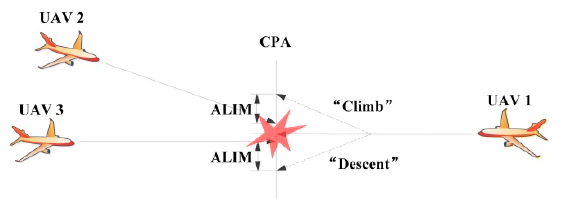
Figure 1. Traffic alert and CA (collision avoidance) system (TCAS) coordination for multi-unmanned aerial vehicles (UAVs).